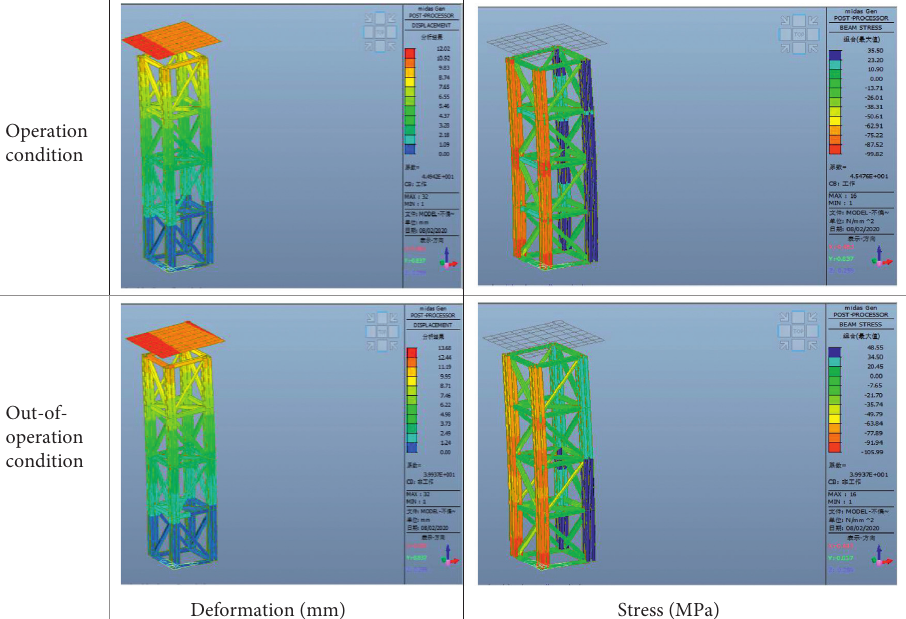
Figure 6: Deformation and stress of lattice columns in a vertical state.